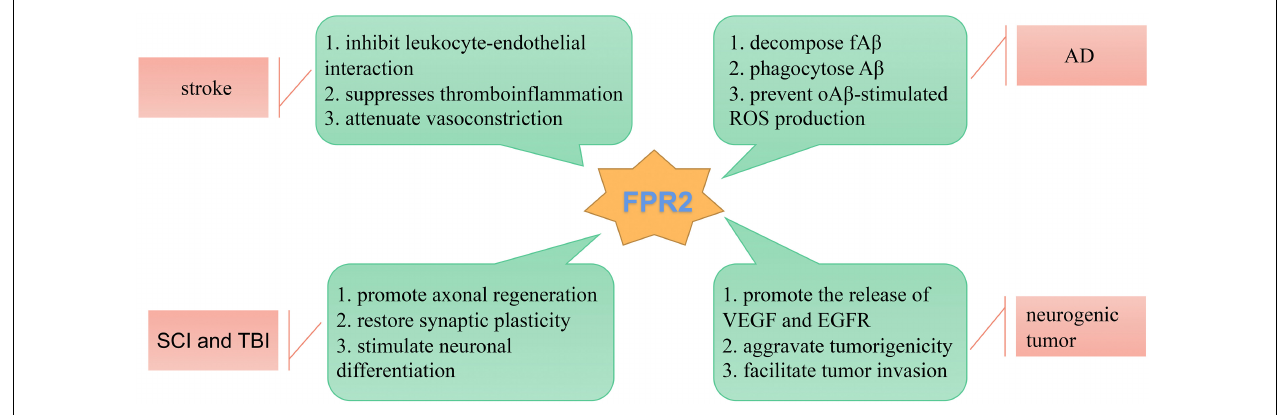
FIGURE 3 | Schematic diagram illustrating the role of FPR2 in neurological diseases. FPR2 acts as a key molecule that mediates the active resolution of inflammation-related neurological diseases.